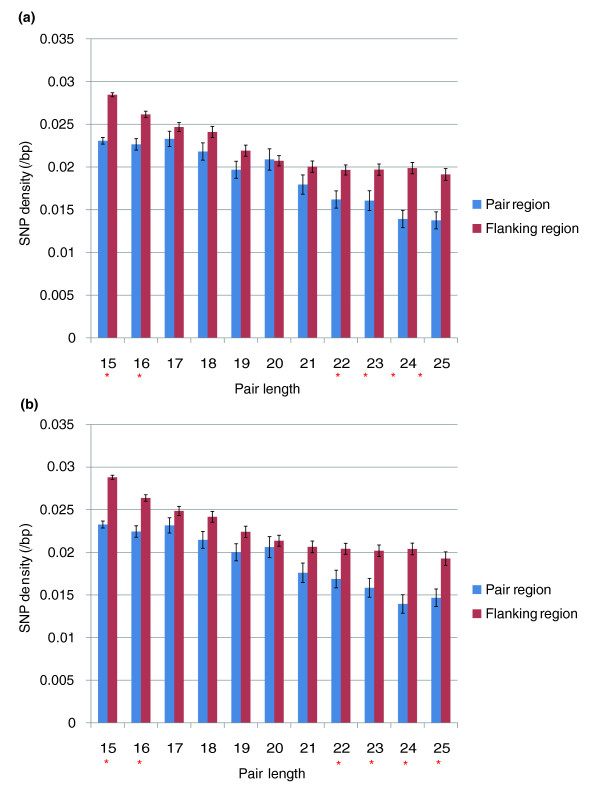
The mean SNP density difference between the pair region and the flanking region. (a) Short pairs without repetitive element pairs. (b) Short pairs with repetitive element pairs. Asterisks indicate a significant difference between the pair region and the flanking region, P < 0.01 (chi-square test). Error bars represent the standard error.